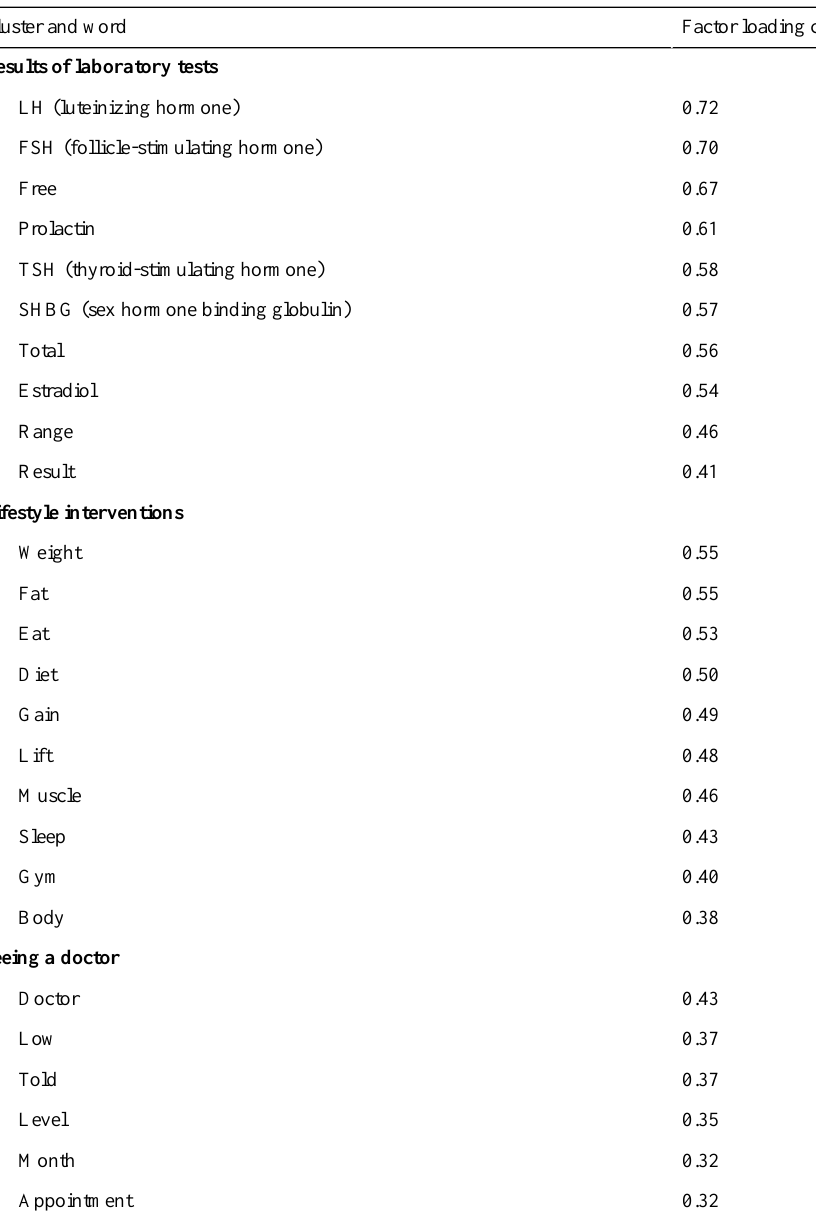
Table 1. Thematic clusters, word frequencies, and associated factor loading coefficients derived from the meaning extraction method with principal component analysis of parent posts from the Reddit community r/Testosterone